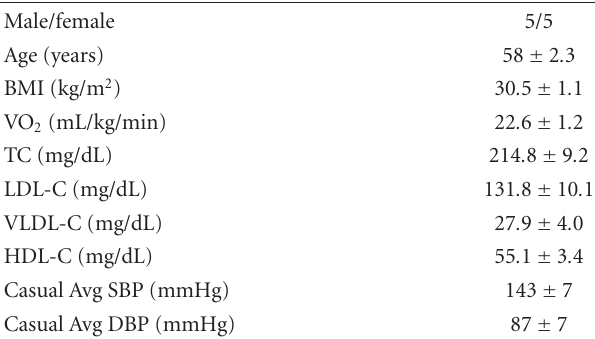
Table 2: Baseline demographic and clinical characteristics.